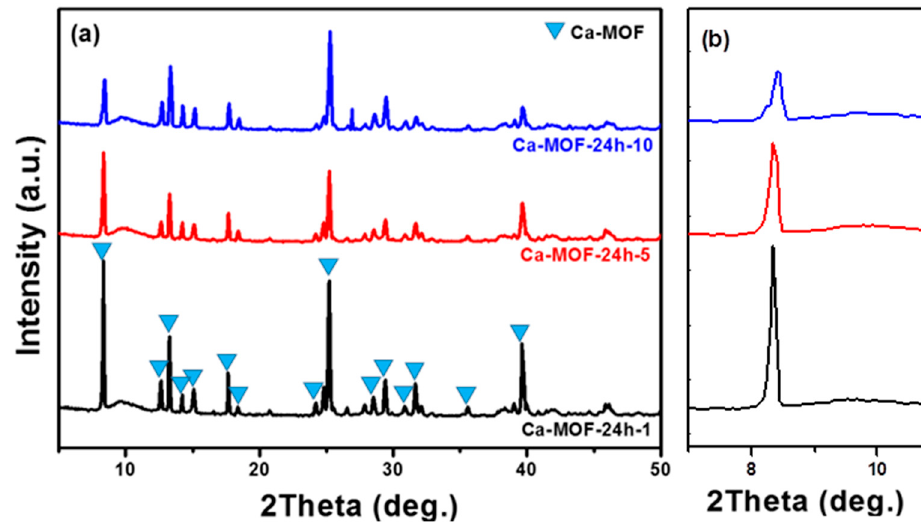
Figure 3. ( a ) XRD patterns of Ca-MOF-24h-y at different CH 3 COOH concentrations and ( b ) enlargement of the XRD pattern in selected 2 theta regions.